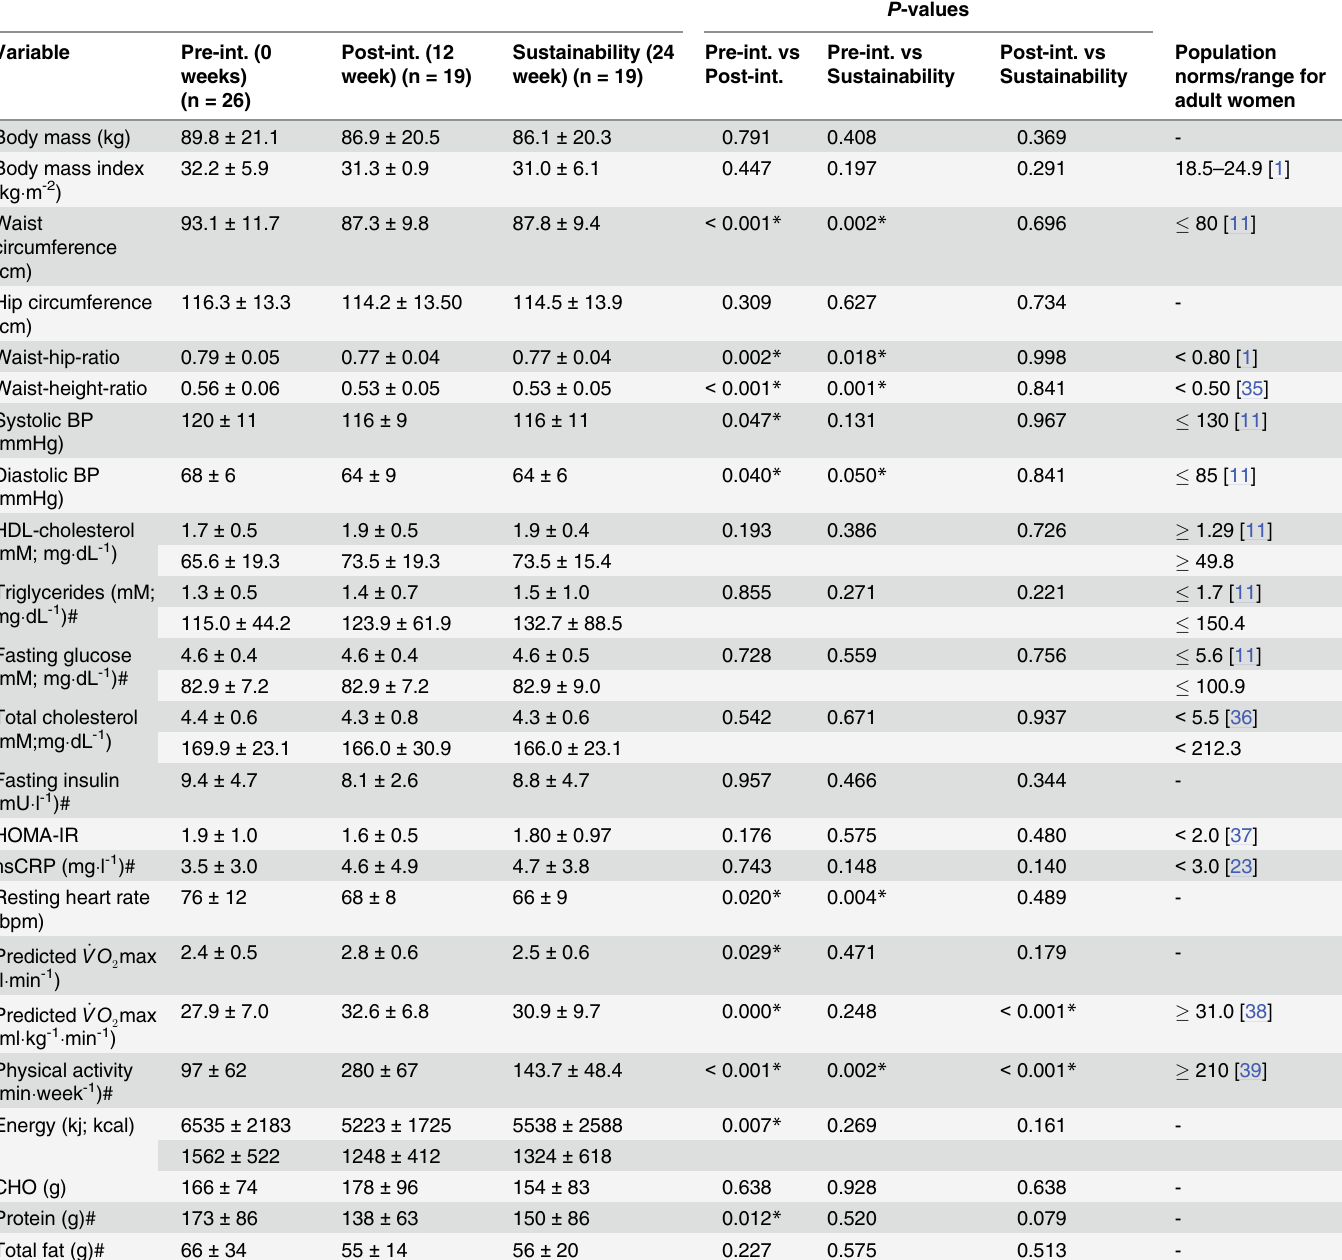
Table 2. Within-group comparisons of cardiometabolic risk factors for the intervention group at pre-intervention, post-intervention, and sustainability. Variable Pre-int. (0